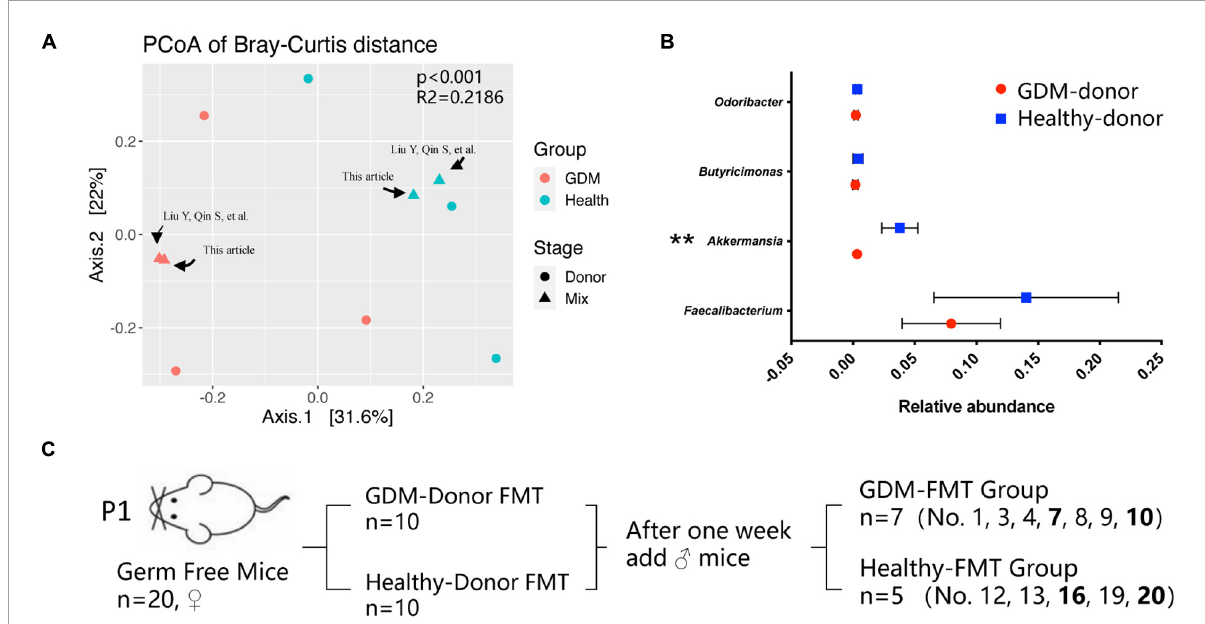
FIGURE1 Gestational diabetes mellitus mouse model construction. (A) PCoA at the genus level based on Bray − Curtis distance is shown along the first two principal coordinate (PC) axes. Individual samples are represented by blue (healthy pregnancy) and red (GDM), and different stages are represented by triangles (mixed sample) and points (donor sample). (B) The bacterial relative abundance of bacteria at the genus level. The data are shown as the median and interquartile range. (C) Schematic diagram of the gestational diabetes mellitus mouse model. Number 2 mice in the GDM-FMT group were died naturally for unknown reasons. Numbers 5, 6, 11, 14, 15, 17, and 18 mice were not conceived. ** P <